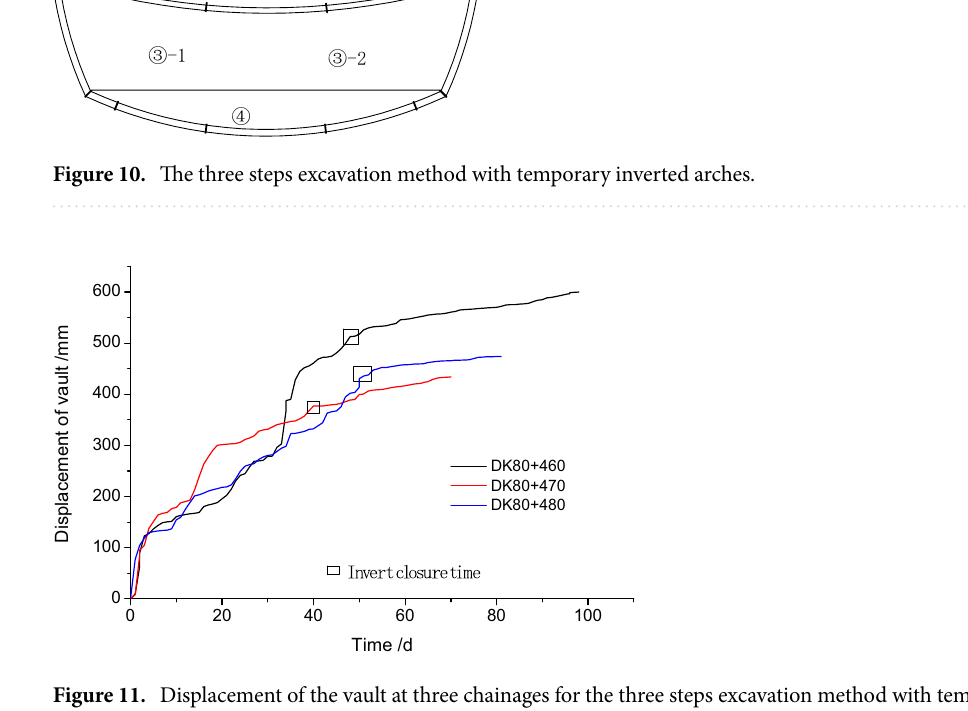
Figure 11. Displacement of the vault at three chainages for the three steps excavation method with temporary inverted arches.